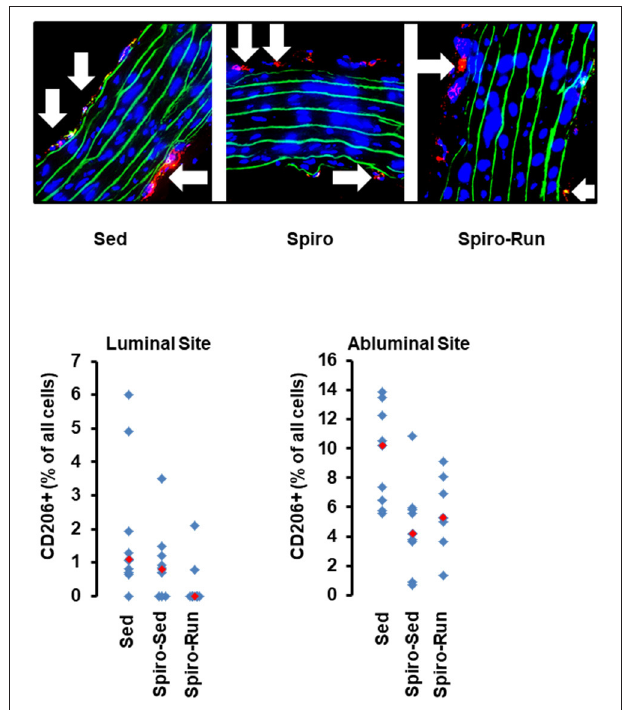
FIGURE 8 | Histological cross sections from aortae of hypertensive rats treated with spironolactone (see Figure 7 ). Top: Representative slights from confocal laser microscopy used to count the number of CD206 + cells (in red) normalized to the total cell number as calculated by DAPI-stained nuclei in blue. Lamina elastica is seen in green. Bottom: Quantification of different slices from n = 5 rats each group. Red rectangles indicate the median, blue rectangles individual data